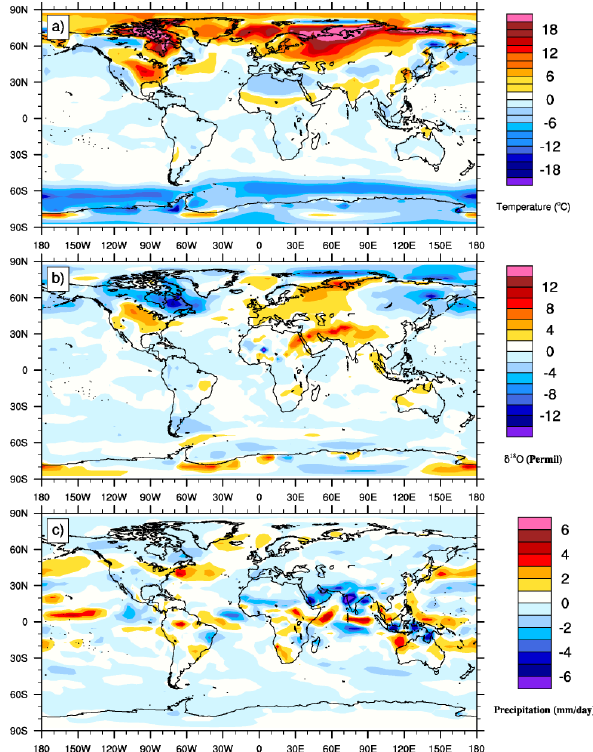
Fig. 8. The difference of (JJA − DJF) in LGM-combined experiment from the (JJA − DJF) in the control run (a) surface temperature ( ◦ C), (b) δ 18 O precip (‰), and (c) total precipitation (mmday − 1